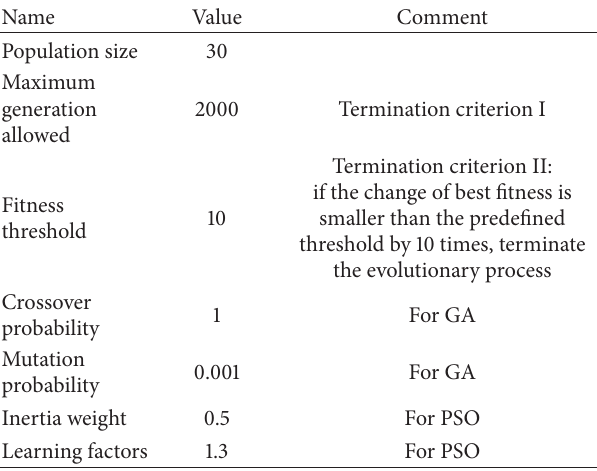
Figure 10: Apply individual crossover operator to generate a new offspring from the given parents. Table 1: Experiment